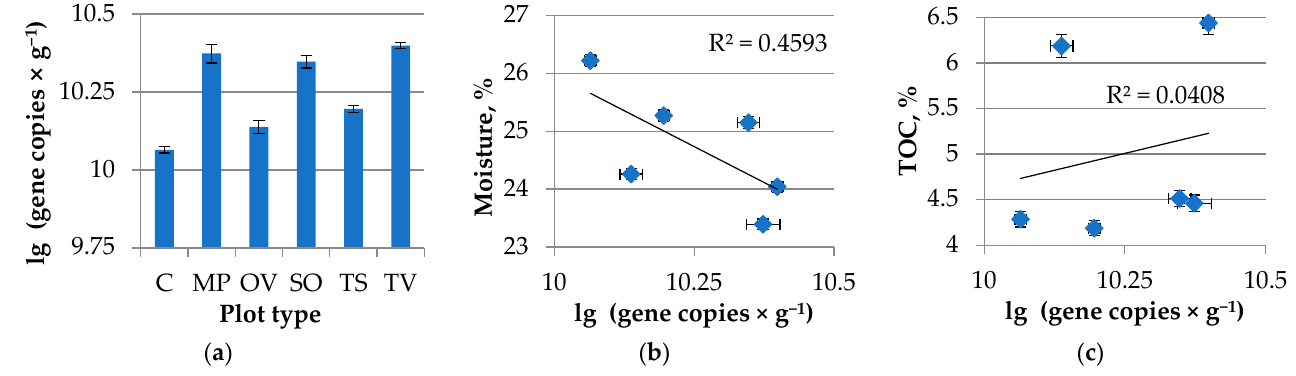
Figure 2. ( a ) Bacterial gene abundance in Lamiacea L. medicinal plants rhizosphere. MP is